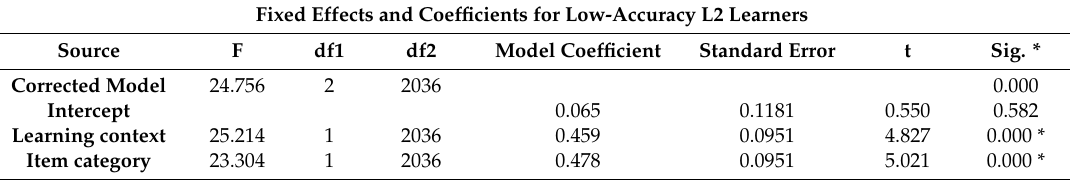
Table 7. Overview of main effects from binomial logistic regression in low-accuracy L2 learners.